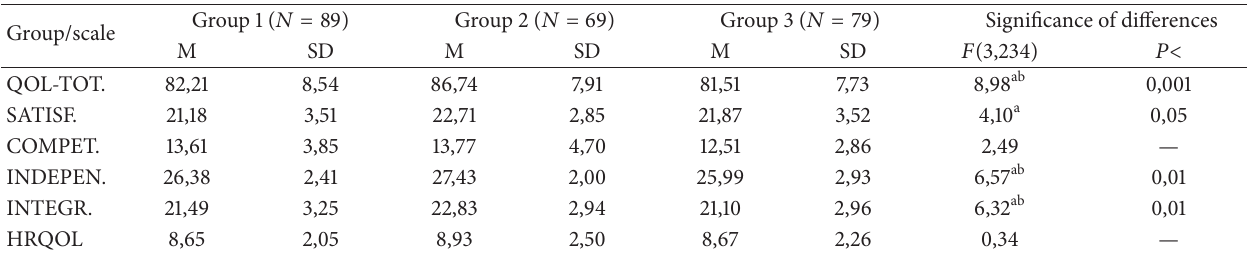
a Significant difference between groups 1 and 2, 𝑃 < 0,05. b Significant difference between groups 2 and 3, 𝑃 <